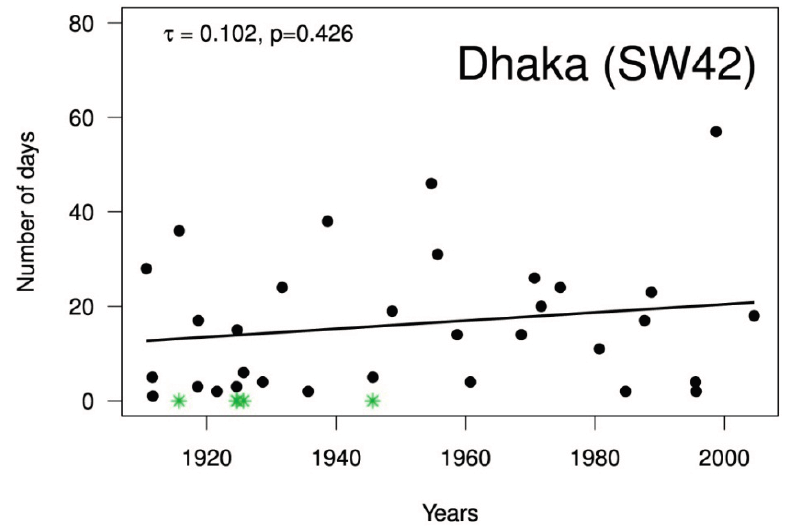
Figure 5. Duration of flooding Dhaka, 1909–2009. Years in which two flood events were counted as one are marked by green